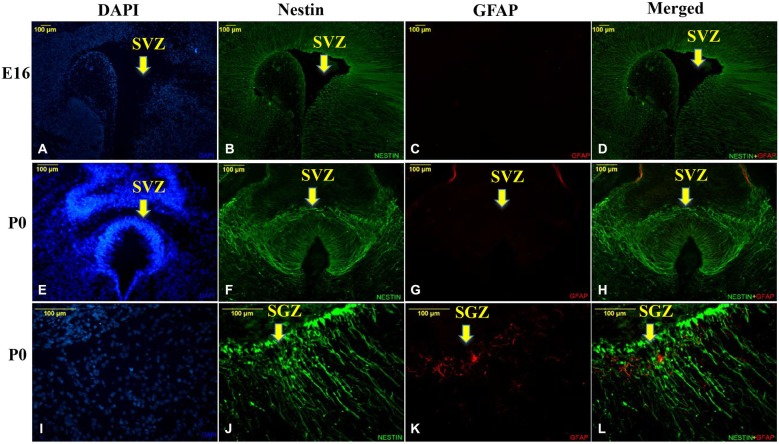
No GFAP expression in the Radial progenitors at SVZ and SGZ during embryonic life and around birth. Immunofluorescence staining for DAPI (blue; A,E,I), Nestin (green; B,F,J) and GFAP (red; C,G,K). Merged images are shown in (D), (H) and (L). Radial glia and progenitors uniformly express nestin throughout the embryonic and early neonatal life. No GFAP co-immunostaining with nestin was observed.